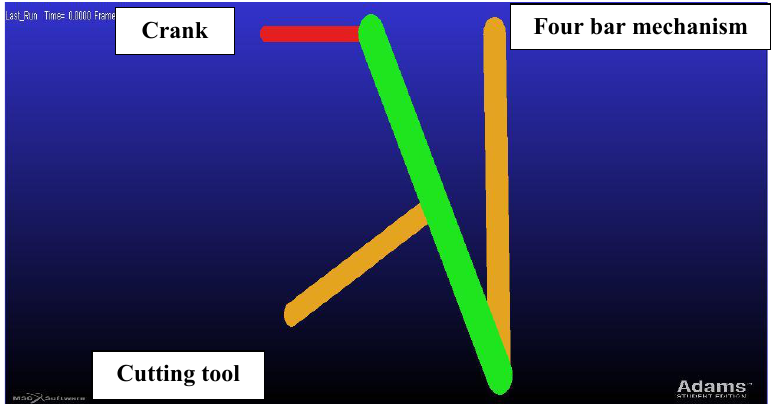
Figure 7: Model of Four bar mechanism in MSC ADAMS